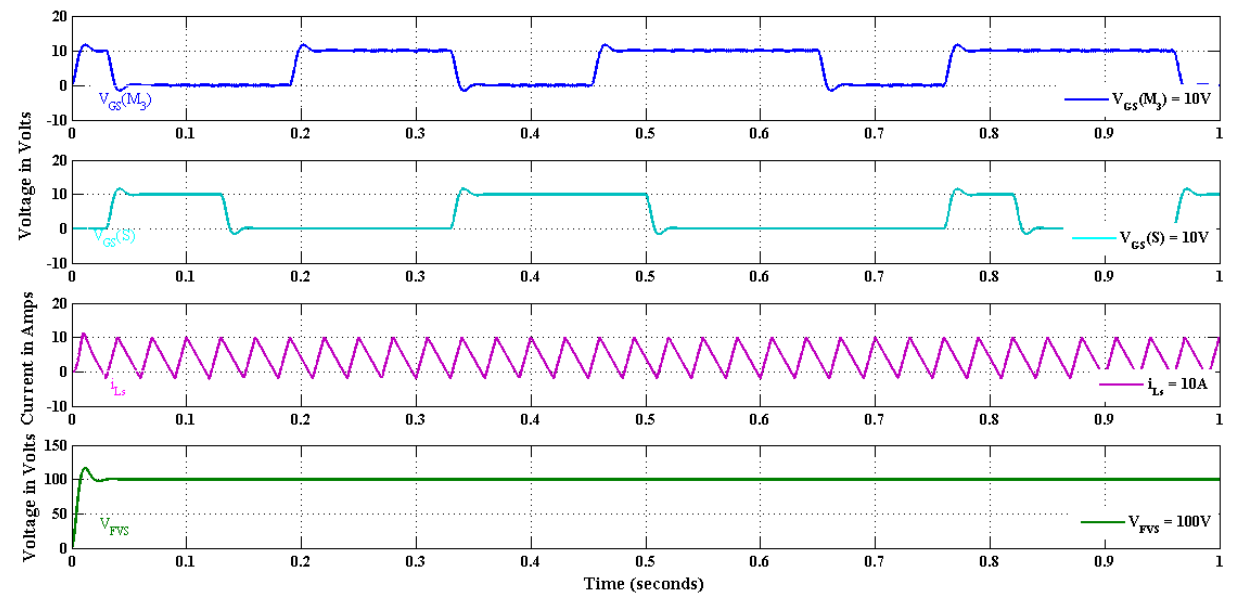
Figure 16. Gate signals, output voltage and inductor currents for buck mode.